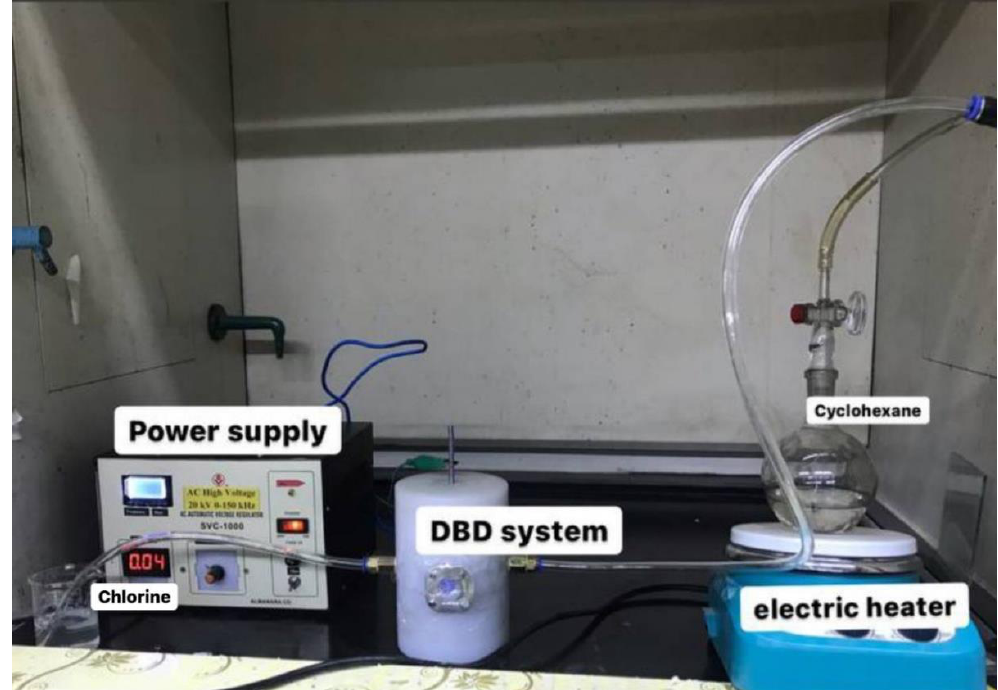
Figure 1: DBD System for Organic Compound